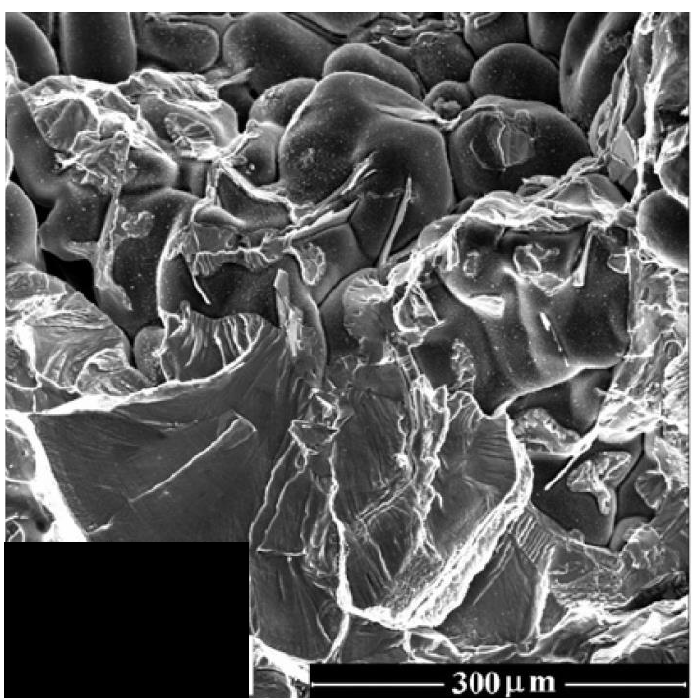
Figure 14. A pore found on the fracture surface of one of the castings in Figure 13, showing the presence of oxide films on the surface of the pores. The films are the remaining half of the bifilm, or bubble, and appear to have been sucked into the inter-dendritic regions, probably as a result of shrinkage during freezing Reprinted with permission from ref. [56]. Copyright 2022 Elsevier.